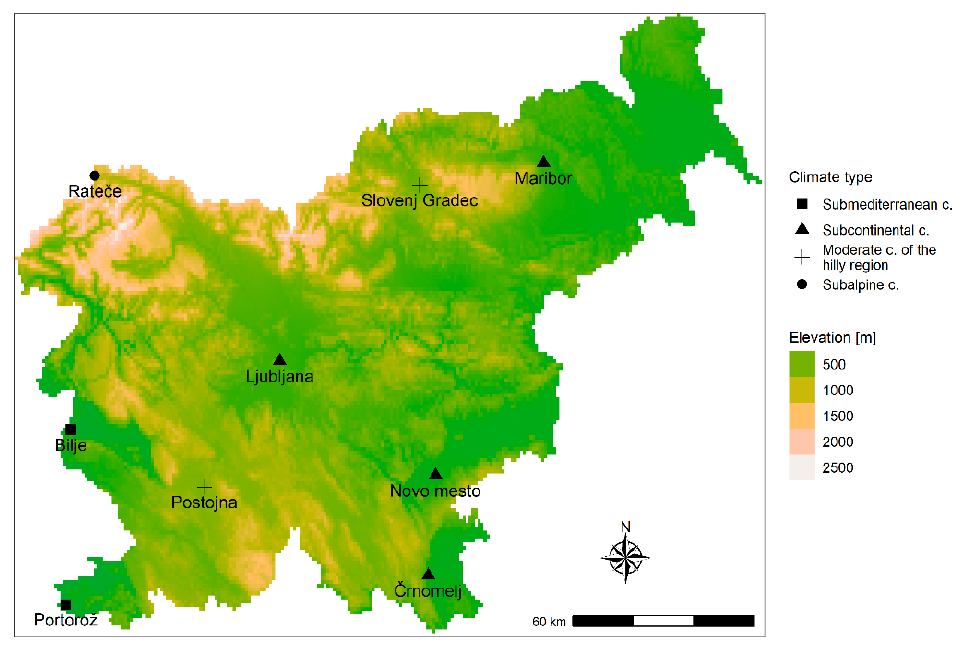
Figure 1. Distribution of selected meteorological stations on the base of climate regions of Slovenia. Table 1. Summer (June, July, August) mean values ± standard deviations of air temperature (T), relative humidity (f), wind speed (v), and cloudiness (N) at 14:00 CEST for studied locations in the period 2000–2021.